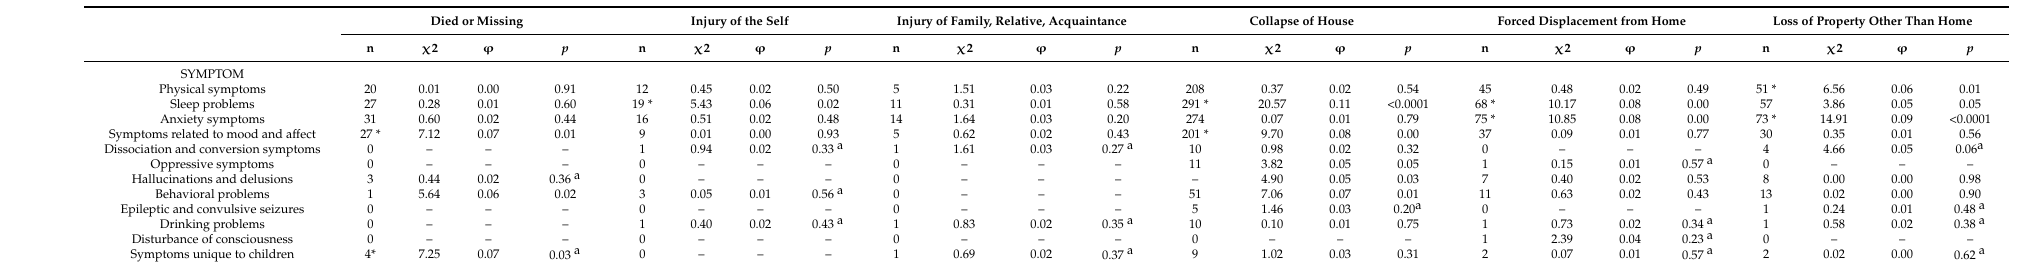
Table 5. Symptoms in Four Disasters: Comparison with Disaster